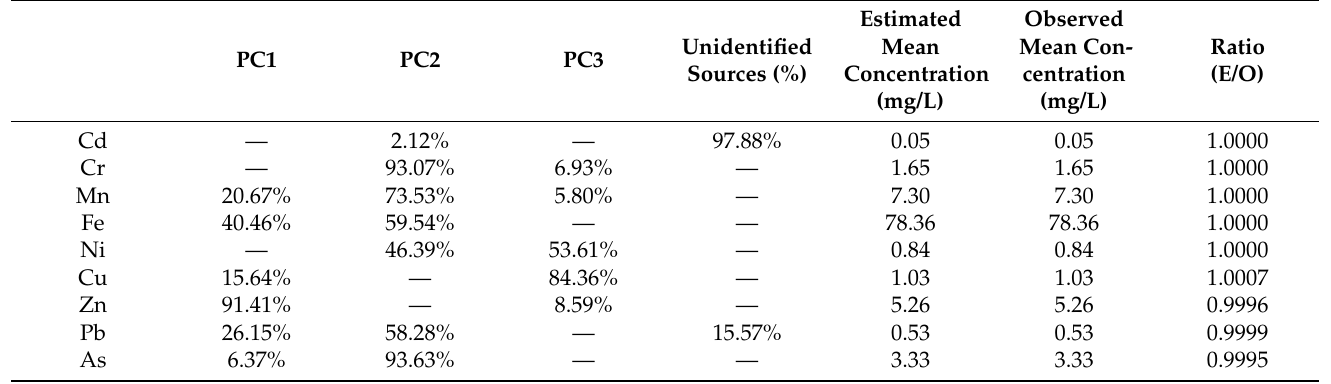
Table 6. Contribution of heavy metals pollution sources in